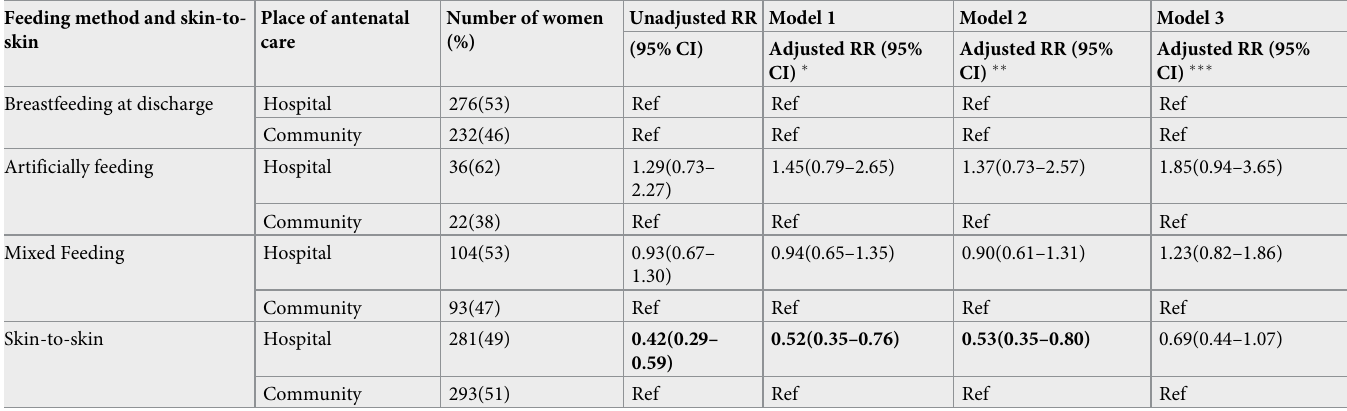
� Model 1: Adjusted for demographics ethnicity, age, parity, IMD score, social risk and medical risk factors. �� Model 2: Model 1 plus adjusted for model of care. ��� Model 3: Model 2 plus Adjusted for service provider